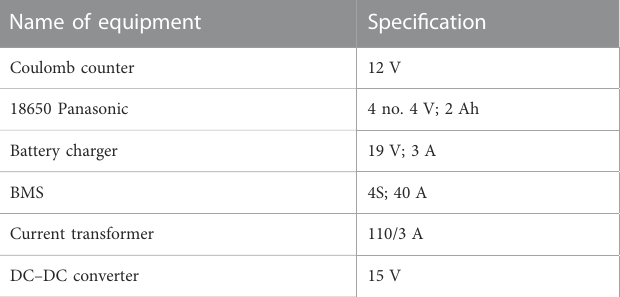
TABLE 1 Experiment material speci fi cations. Name of equipment